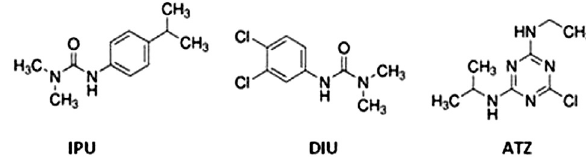
Figure 2: Chemical structure of isoproturon (IPU), diuron (DIU) and atrazine (ATZ).